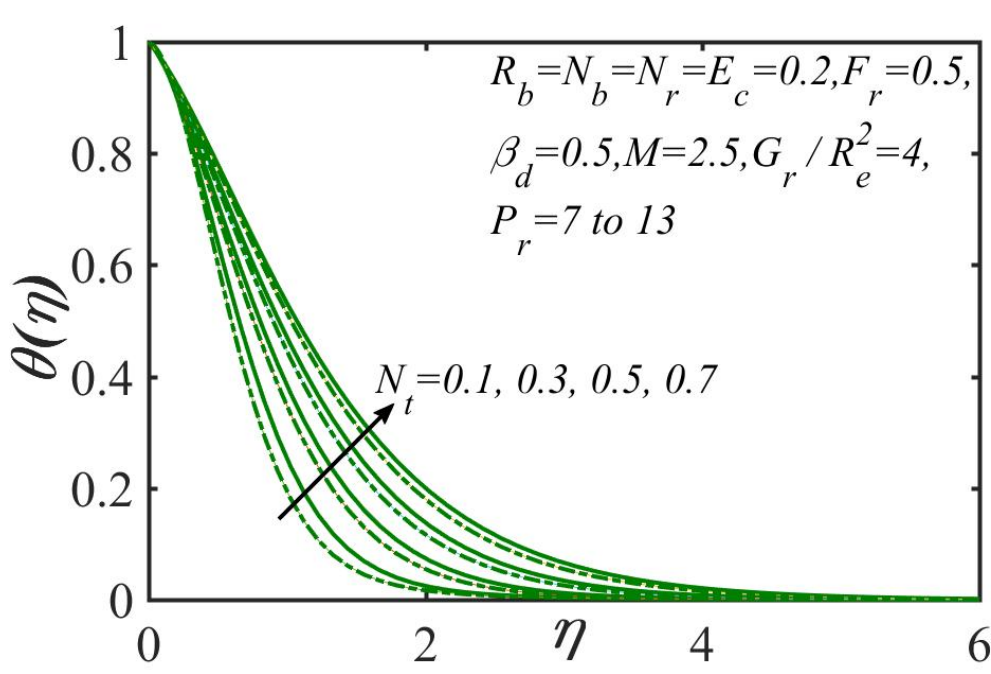
Figure 7. Influence of the thermophoresis parametric quantity N t and Prandtl number “ P r ” on temperature distribution. Solid line: P r = 7, Dotted line: P r = 13.